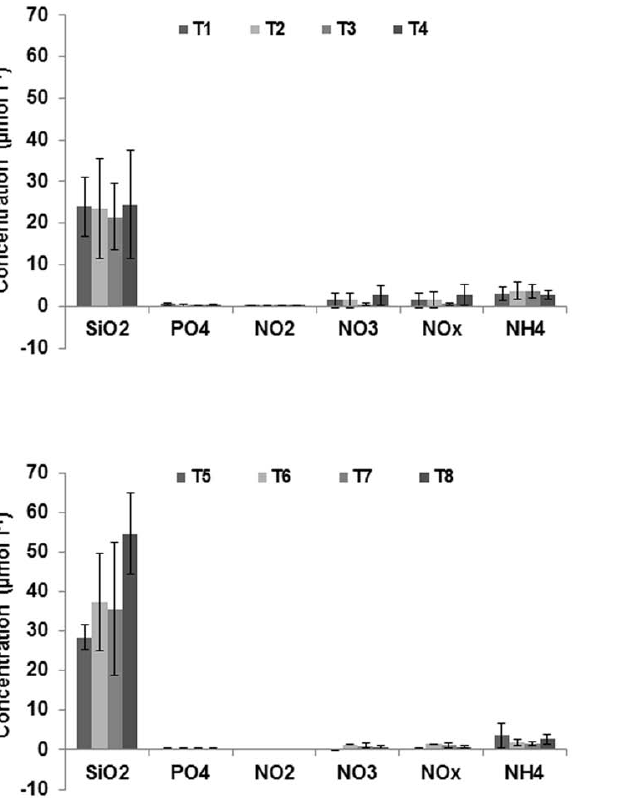
Fig. 6. Concentrations of inorganic nutrients in (a) the Lena Delta transects (T5 = Olenek channel, T6 = Trofimov channel, T8 = , Bykov channel, and (b) the coastal transects T. Values were pooled across the stations in each transect. Error bars indicate the standard deviation for the stations per